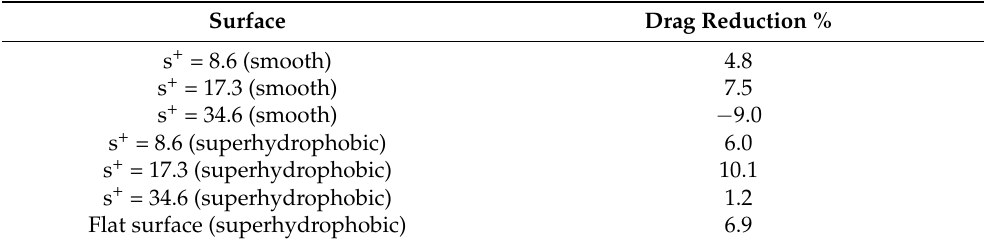
Table 1. Comparison of drag reduction between superhydrophobic surface and smooth surface. Reprinted with permission from Ref [100]. Copyright 2018